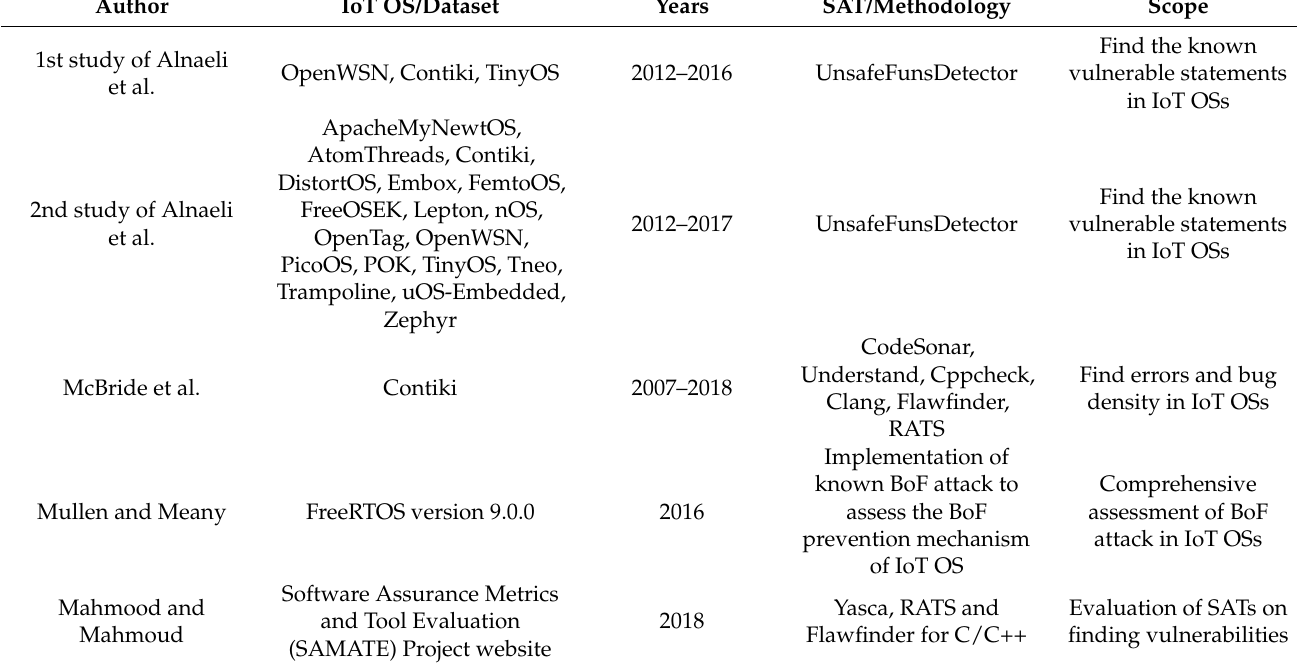
Table 2. Brief overview of related